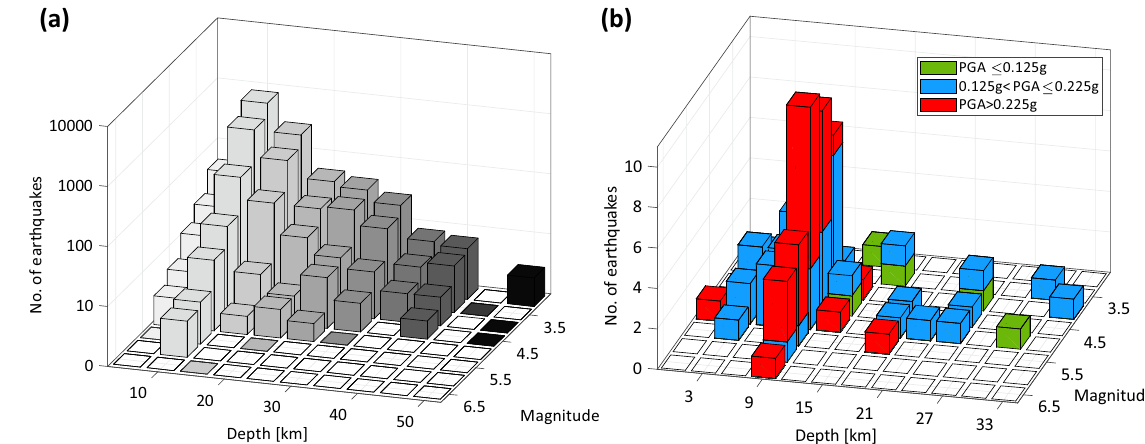
Figure 2. Earthquakes, the ShakeMap of which are considered in this study, described in terms of magnitude and hypocentral depth distribution ( a ); events causing exceedance of the 50 years design hazard in terms of PGA described in terms of magnitude and hypocentral depth, and also in terms of the hazard level of the region were they have occurred ( b